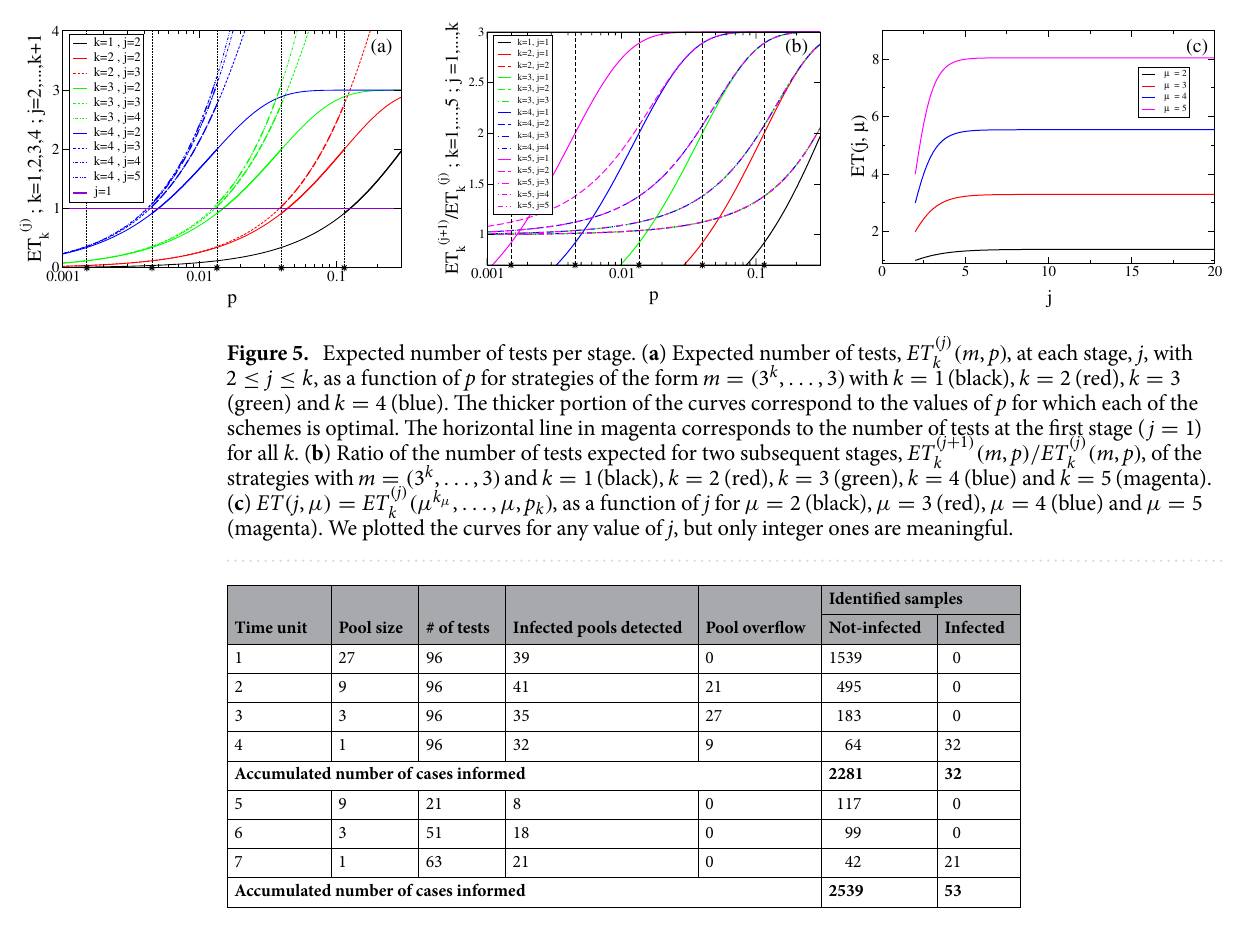
Table 1. Running the m = ( 27, 9, 3 ) strategy in parallel on 96 pools per time unit for an example with 2592 samples (53 infected). Only after the first 4 time units, it is possible to identify some infected individuals. In the example, the remaining infected individuals are identified at the end. This feature is highlighted in bold in the table by quoting the total number of cases informed after the 4th time unit and at the end.